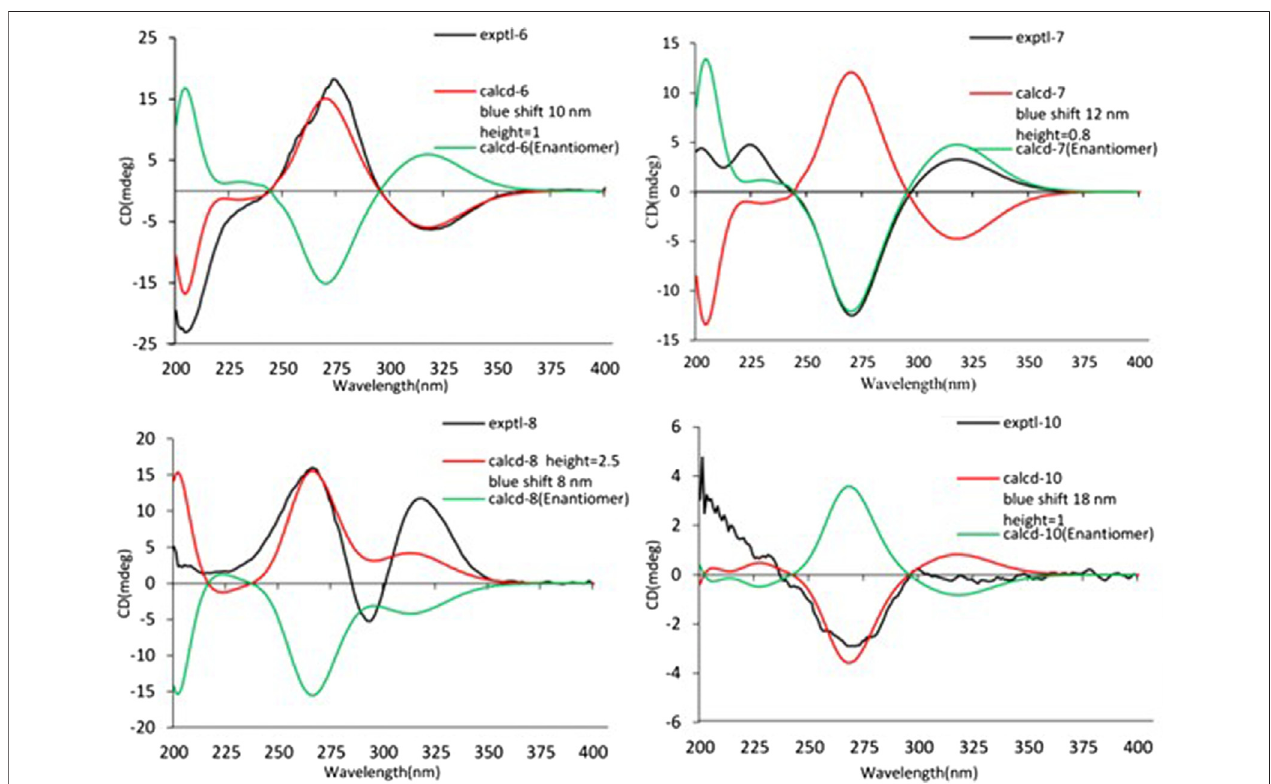
FIGURE 9 | Experimental and calculated ECD spectra of 6 – 8 and